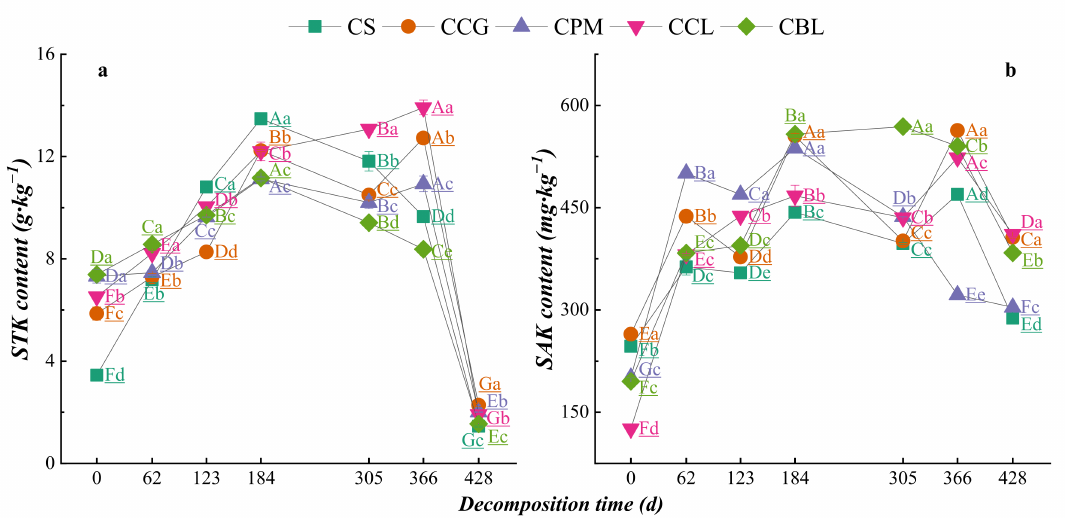
Figure 8. Dynamic changes in soil P contents of different plant residues during decomposition processes. Note: A, B, C—differences between decomposition stages of the same treatment ( p < 0.05); a, b, c—differences between treatments in the same decomposition period ( p < 0.05); ( a )—STP content (g-kg − 1 ); ( b )—SAP content (mg-kg − 1 ).